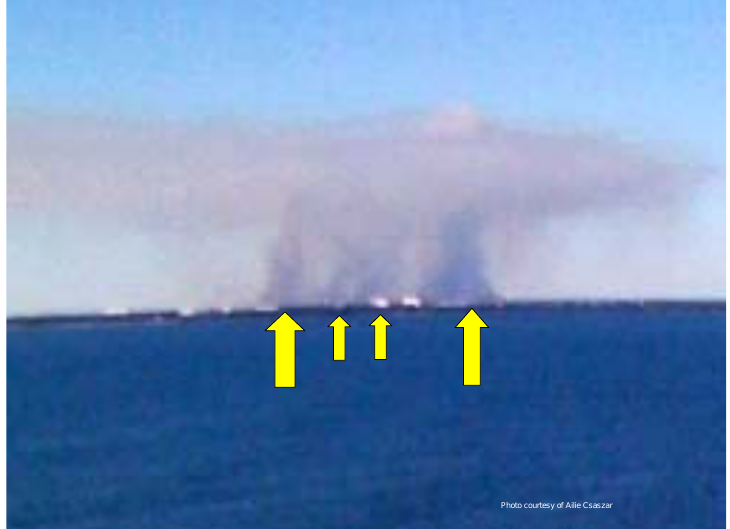
Figure 8. Photo-image of the Block 703C plume taken from a bridge 42 km east-southeast from the burn.